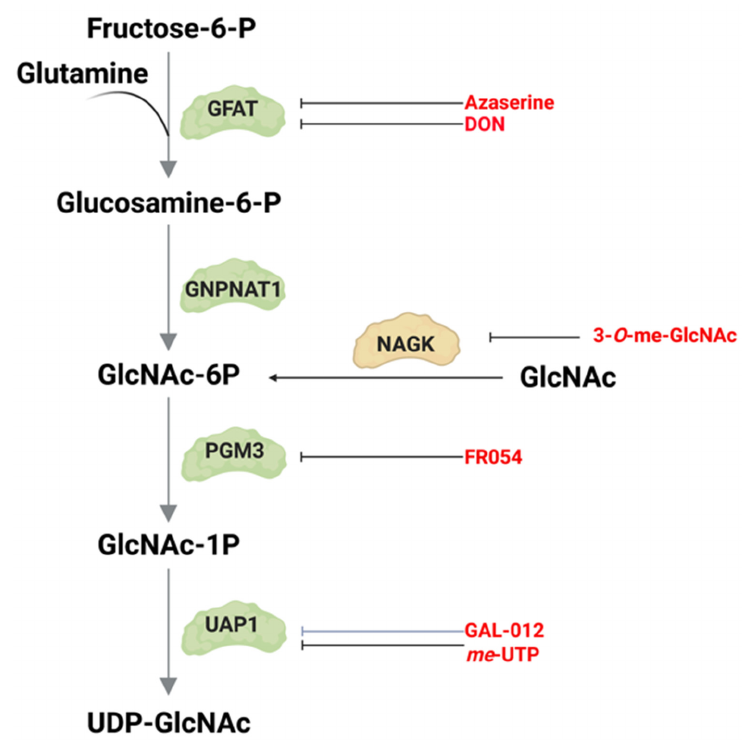
Figure 7. Inhibitors of HBP enzymes.